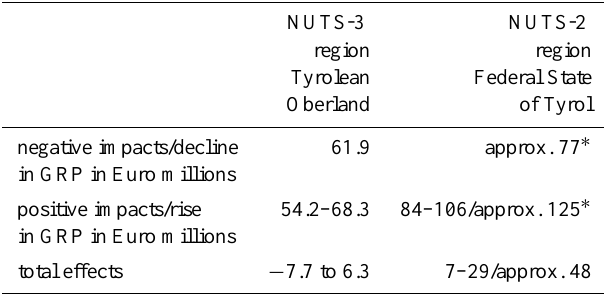
Table 6. Overview of the total effects in GRP Euro million based on own calculations and Sinabell et al.